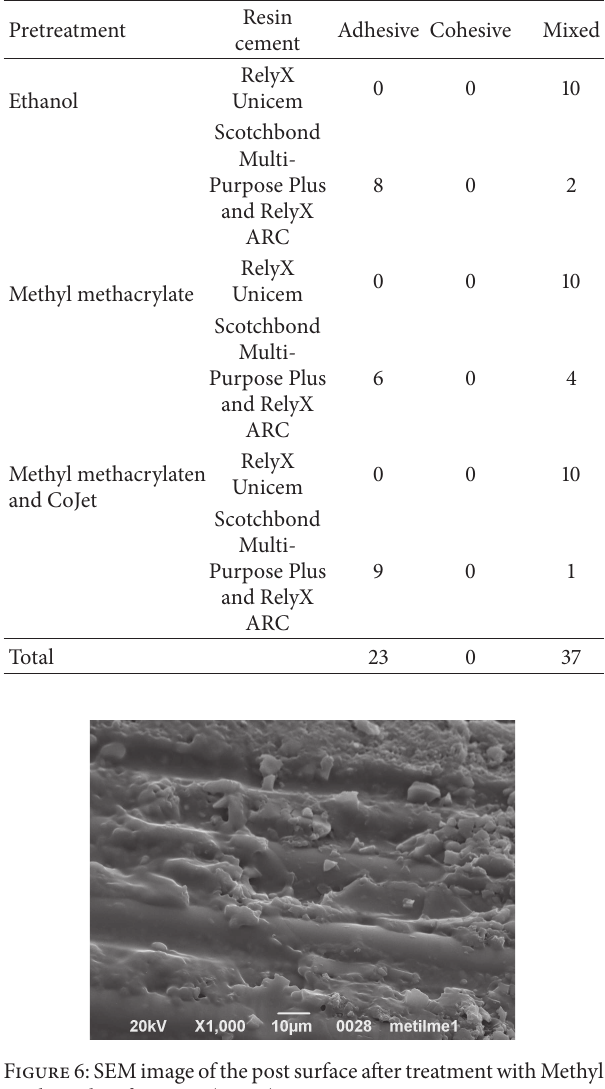
Table 3: Type of failure.